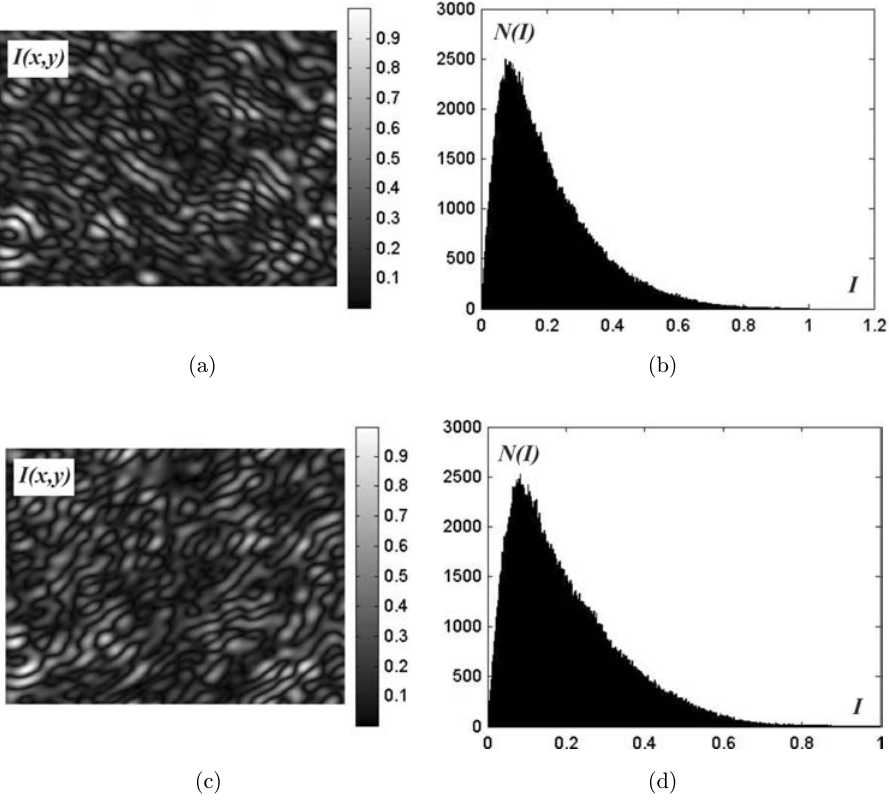
Fig. 2. Coordinate ( I ð x ; y Þ ) and statistical ( N ð I Þ ) distributions of laser auto°uorescence intensities of histological section of biopsy of cervix uteri endometrium in precancer state (dysplasia) for the following polarization states: (cid:4) 0 ¼ 0 (cid:6) — fragments (1), (2); (cid:3) (cid:4) — fragments (5), (6). Explanations are in the (cid:4) (cid:6) — fragments (3), (4); (cid:4) 0 ¼ 90 0 ¼ 0